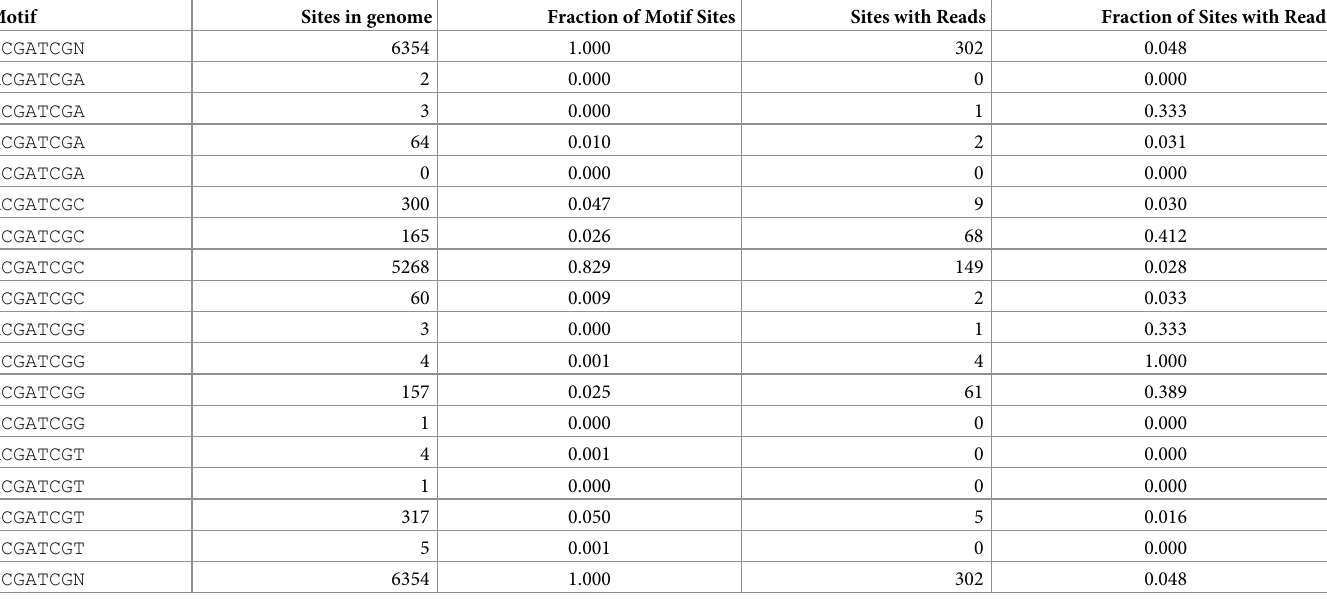
a Fraction of motif sites = fraction of the 6354 NCGATCGN sites that each sequence represents. Sites with reads = number of sites for which eat least one (16,16), (16,17), or (15,16) read was identified. Fraction of sites with reads = sites with reads / sites in